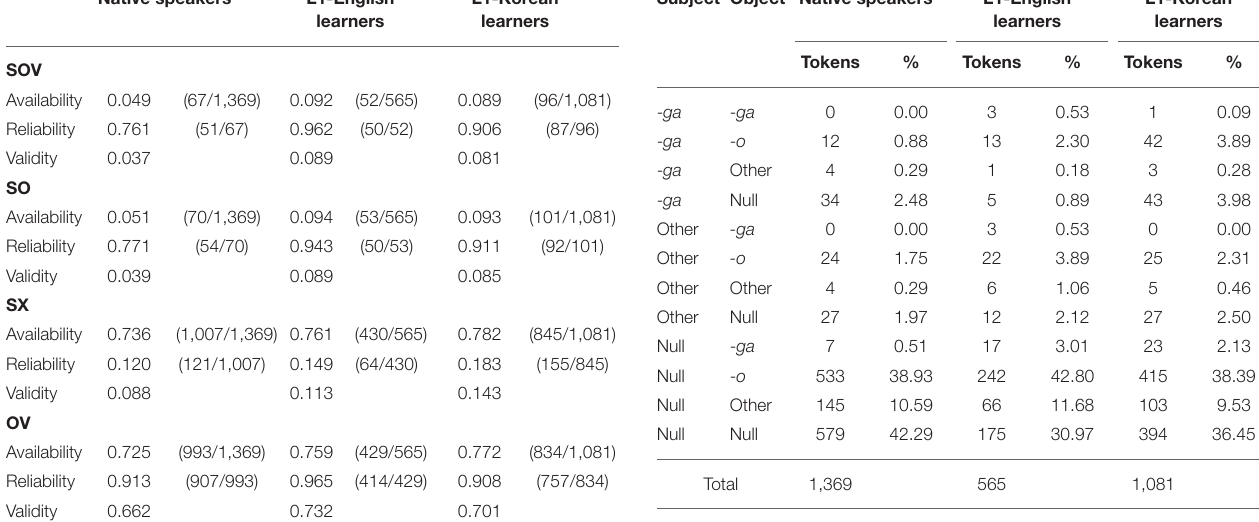
TABLE 6 | Availability, reliability, and validity of word-order cues in all sentences. Native speakers